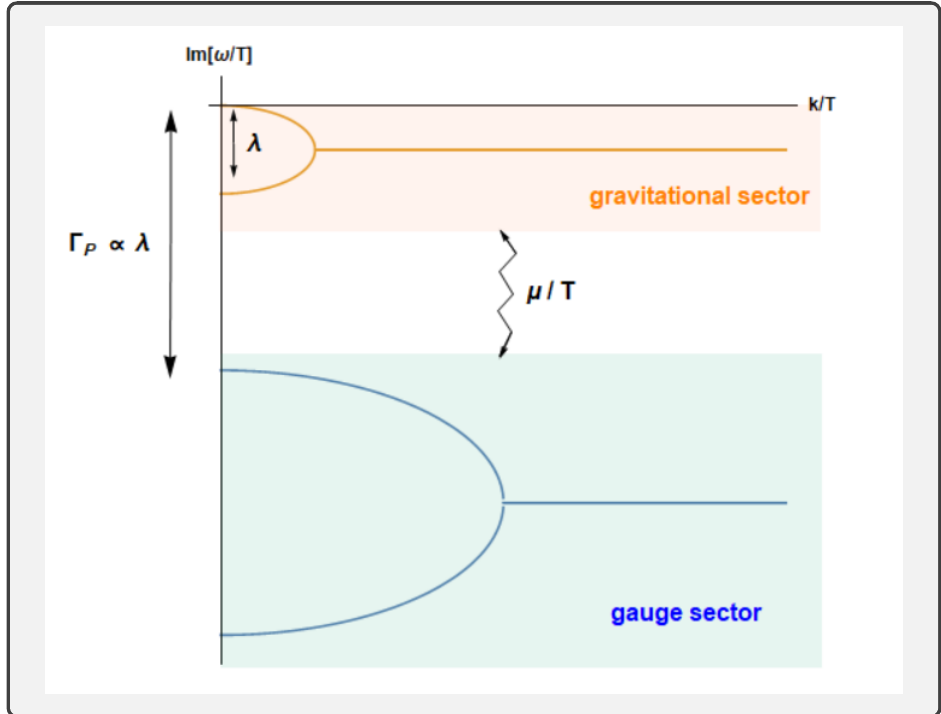
Figure 9 . A simpli(cid:12)ed summary of the interplay between the gravitational sector and the gauge (cid:12)eld sector at (cid:12)nite chemical potential. The dynamics is explained in terms of the chemical potential (cid:22) and the electromagnetic coupling (cid:21) . The zig-zag arrow, mediated by the dimensionless parameter (cid:22)=T , represents the coupling between the gauge sector (blue area) and the gravitational sector (orange area). Increasing the chemical potential, the two sectors become more and more interacting.